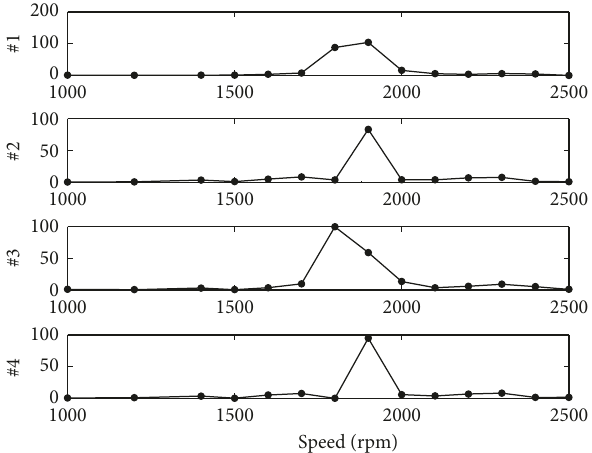
Figure 8: Estimated residual vibration response of measuring planes A and B. #1–#4 correspond to the four measuring